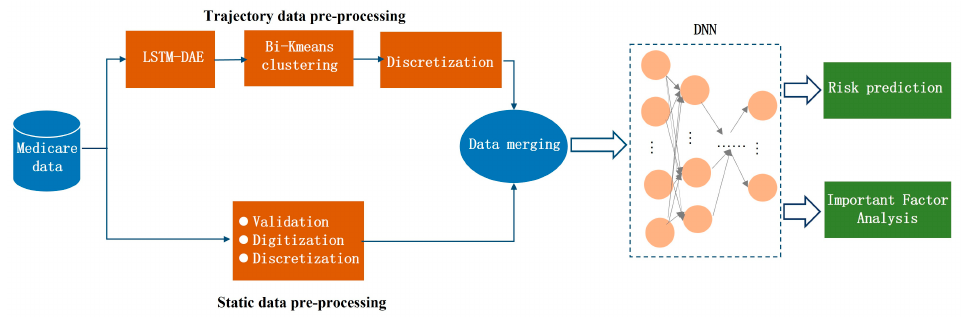
Figure 2. Architecture of the MSNN method.